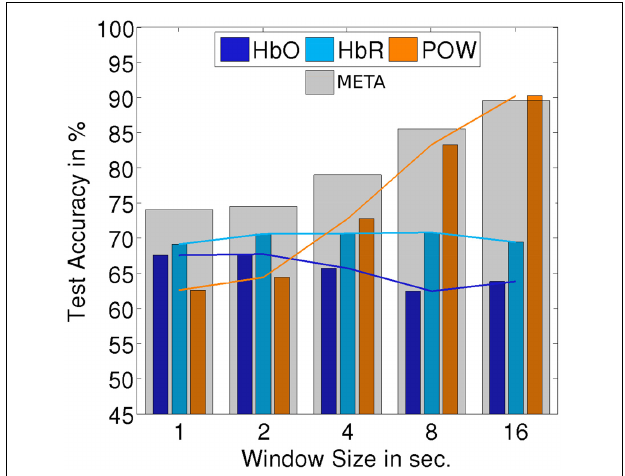
FIGURE 10 | Accuracy for subject-independent classification of AUD vs. VIS on continuous data. Results are in dependency of window size.